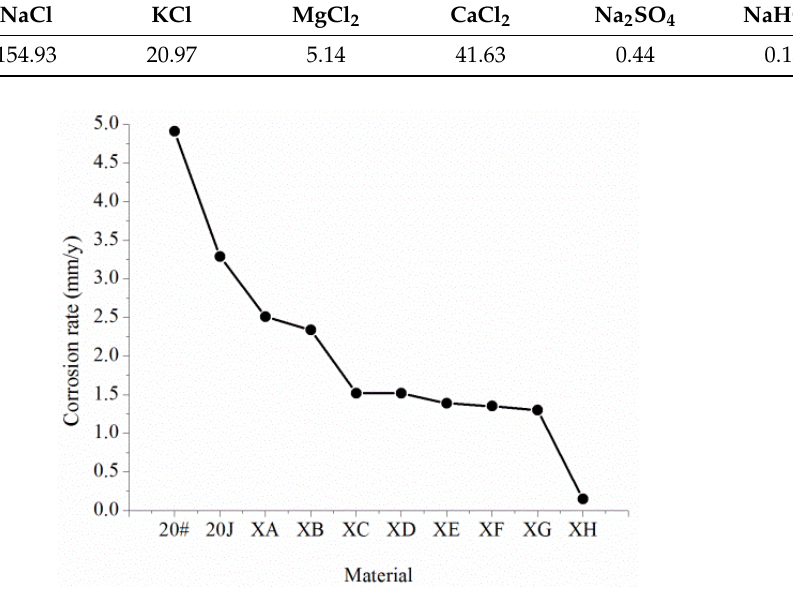
Figure 10. Corrosion rate of different materials.